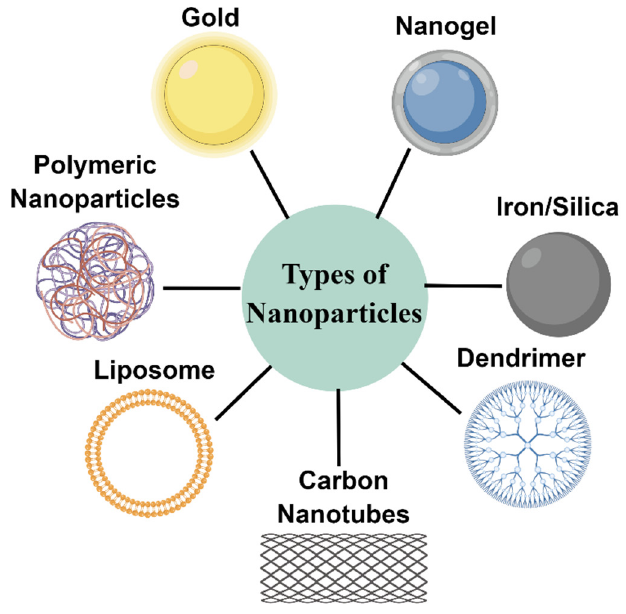
Figure 2. Types of nanoparticles (this figure was created by Figdraw).